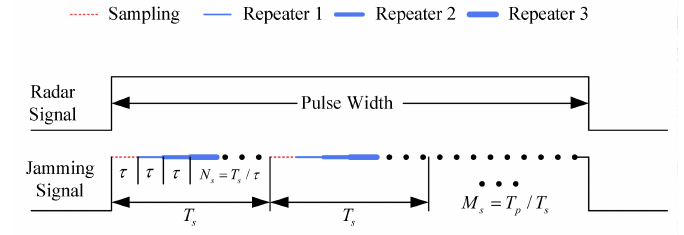
Figure 1. Diagram of the ISRJ